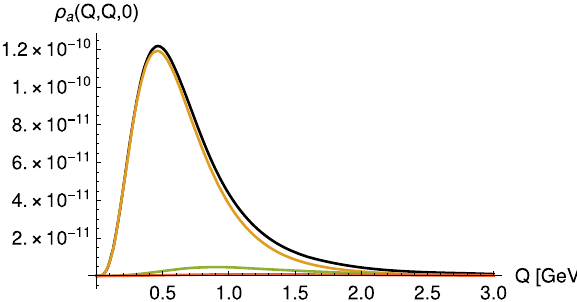
Fig. 8 Single-virtual axial vector TFF from holographic models (SS: blue, HW1: orange, HW2: red) compared with dipole fit of L3 data for f 1 ( 1285 ) (grey band). The parameters of all models are fixed by matching f π and m ρ . The results for HW1 and HW2 almost coincide, with HW2 at most a line thickness above HW1. When the mass scale z − 1 is not fixed by m ρ but instead matched to the pQCD with N c = 3, 0 HW2 (UV-fit) instead gives the significantly larger result denoted by the red dotted line. (Figure taken from [38])